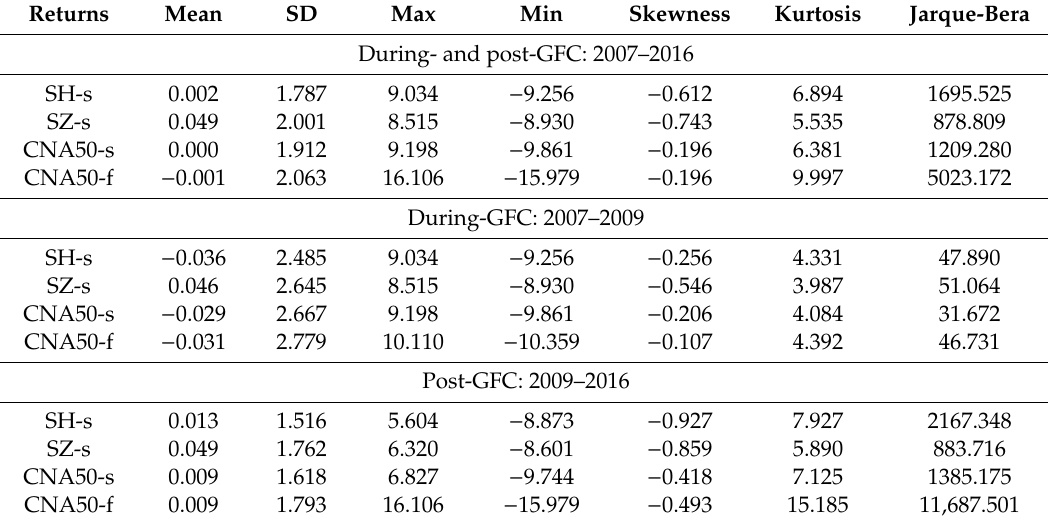
Table 2. Descriptive statistics for